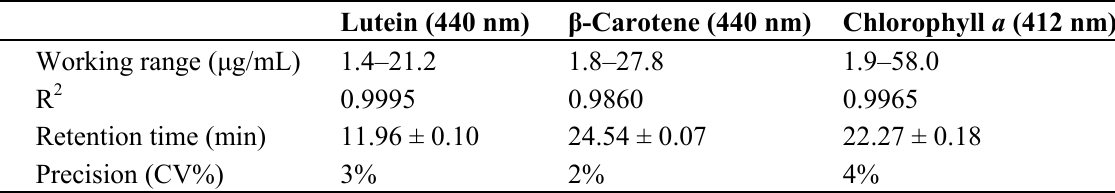
Table 4. Analytical method